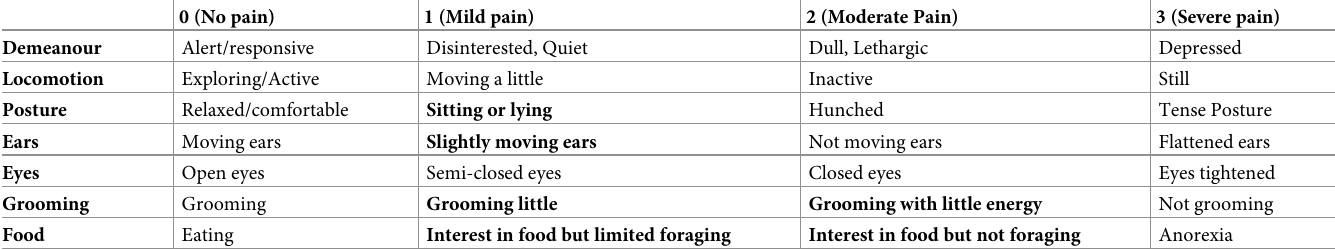
Table 4. Ranking of descriptors on an ordinal scale. The descriptors in bold were added in order to fill the gaps due to a small number of descriptors within the